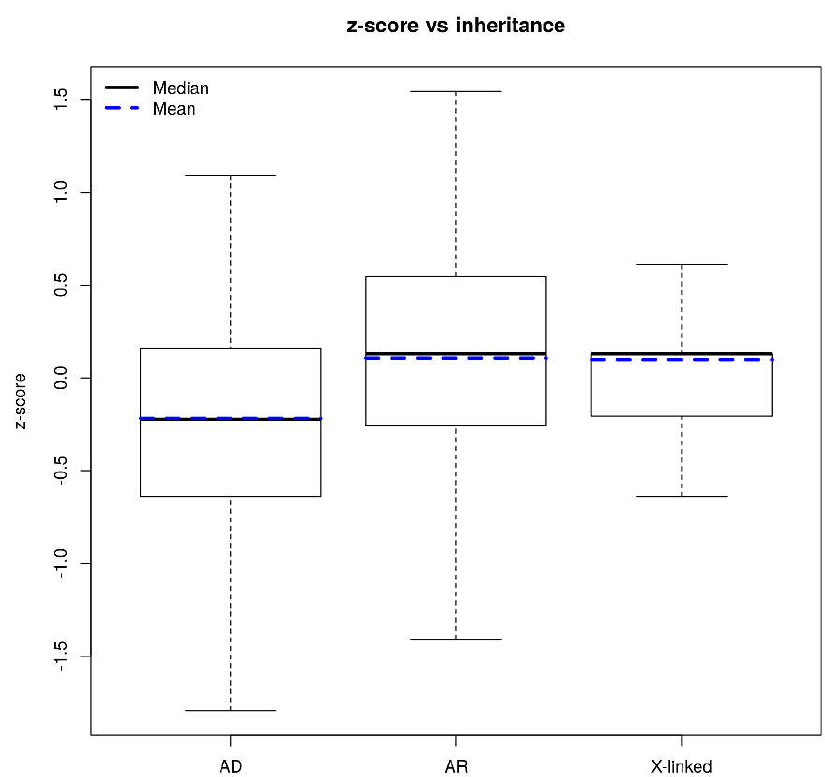
Figure 2. Boxplot (without outliers) of z -score values according to gene inheritance. AD: autosomal dominant; AR: autosomal recessive; X-linked. dominant; AR: autosomal recessive;